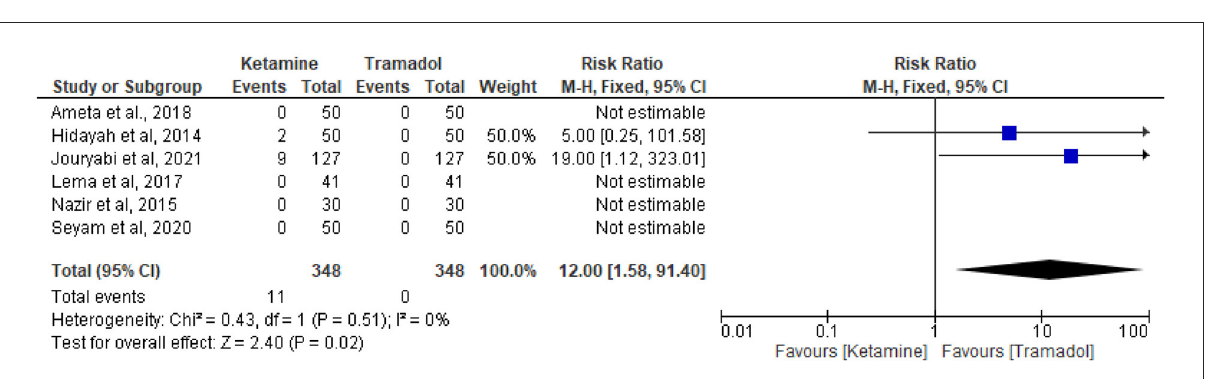
FIGURE9 The effect of tramadol vs. ketamine on the incidence of